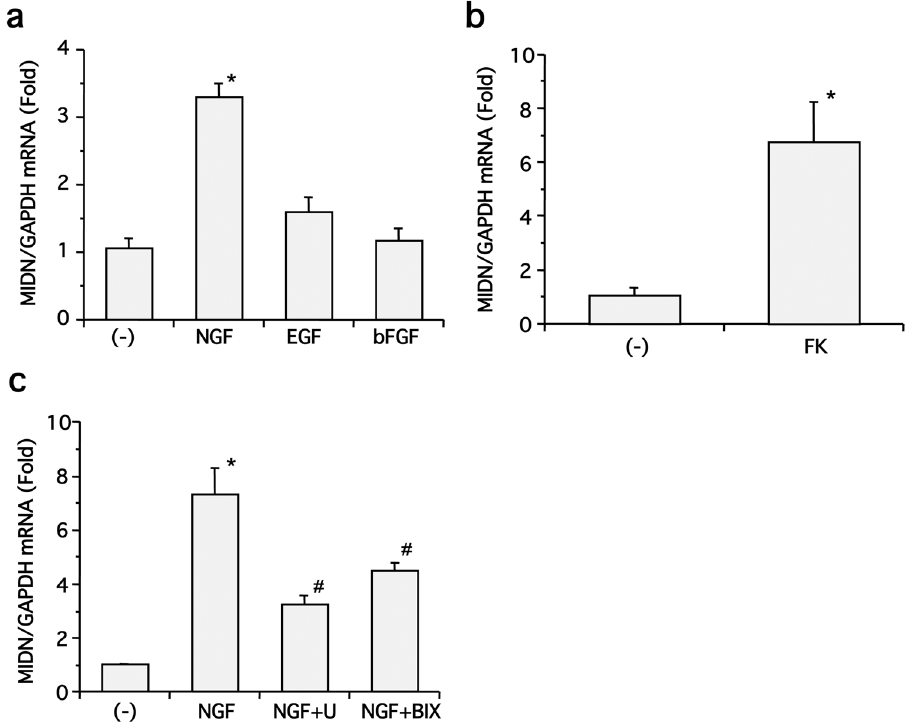
Figure 2. NGF-induced MIDN gene expression is mediated by ERK1/2 and ERK5, and cAMP signaling promotes MIDN gene expression in PC12 cells. ( a ) Serum-starved PC12 cells were stimulated with or without 100 ng/ml of NGF, EGF, or bFGF for 2 h, then MIDN gene expression was examined by qRT-PCR. NGF significantly induced MIDN gene expression compared with drug-free control ( * p < 0.05, n = 6). ( b ) Serum- starved PC12 cells were stimulated with or without forskolin (FK, 10 μ M) for 2 h, then MIDN gene expression was examined by qRT-PCR. Forskolin significantly induced MIDN gene expression compared with drug-free control ( * p < 0.05, n = 3). ( c ) Serum-starved PC12 cells were stimulated with or without 100 ng/ml NGF for 2 h in the presence or absence of U0126 (U, 30 μ M) or BIX02189 (BIX, 30 μ M), then MIDN gene expression was examined by qRT-PCR. NGF significantly induced MIDN expression compared with drug-free control ( * p < 0.05, n = 3), and the induction of MIDN expression by NGF was significantly blocked by either U0126 or BIX02189 ( # p <